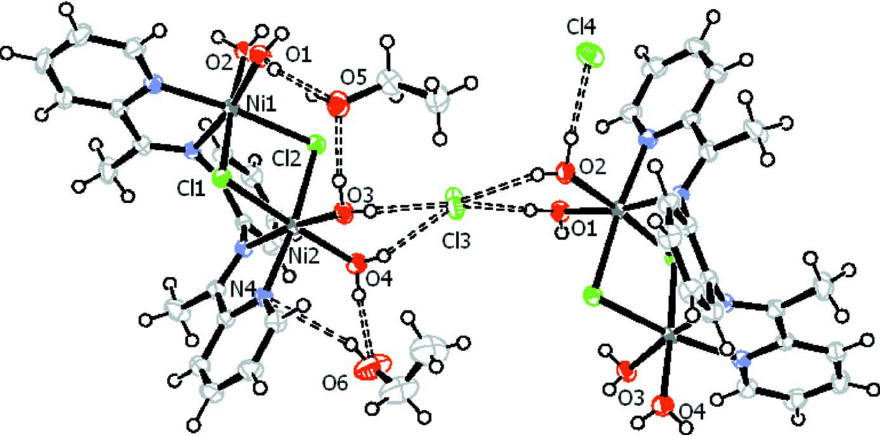
Figure 2 The packing for (I): the broken lines stand for hydrogen